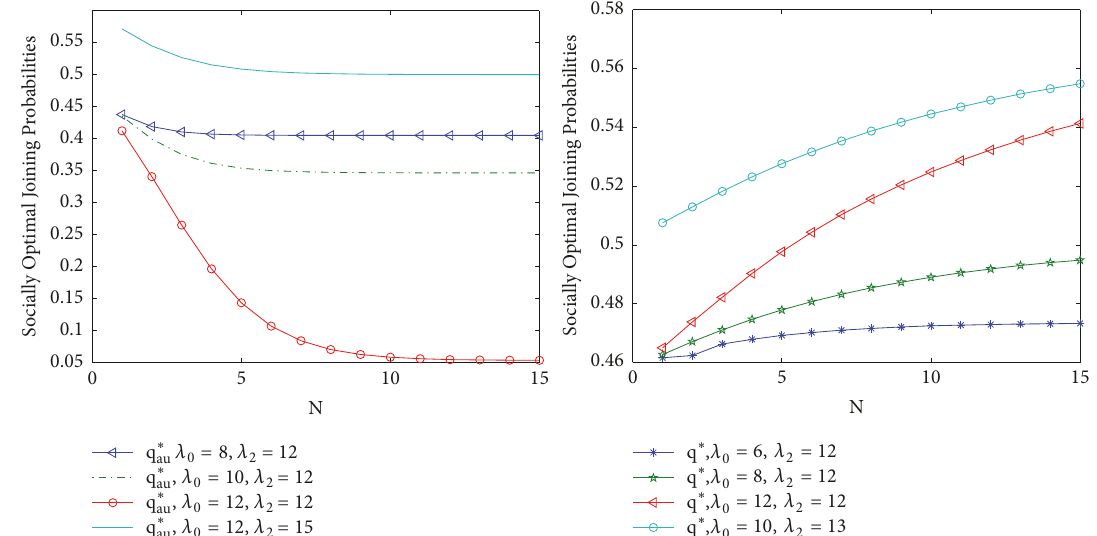
Figure 6: Left: socially optimal joining probabilities for the almost unobservablecase vs. 𝑁 for 𝑅 = 30, 𝐶 1 = 15, 𝐶 2 = 10, 𝜆 1 = 20. Right: socially optimal joining probabilities for the unobservable case vs. 𝑁 for 𝑅 = 30, 𝐶 1 = 20, 𝐶 2 = 15, 𝜆 1 =